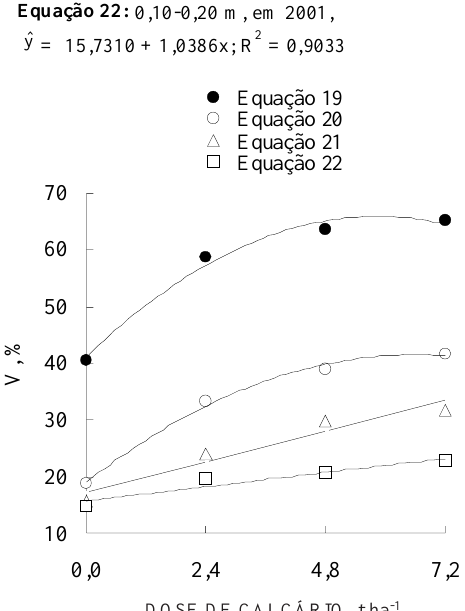
Figura 8. Valores de saturação por bases (V) de acordo com as doses crescentes de calcário distribuído na superfície do solo em 1999. As equações de regressões (linear e quadrática) variam de acordo com as camadas de solo (0,05– 0,10 e 0,10–0,20 m) época e anos de